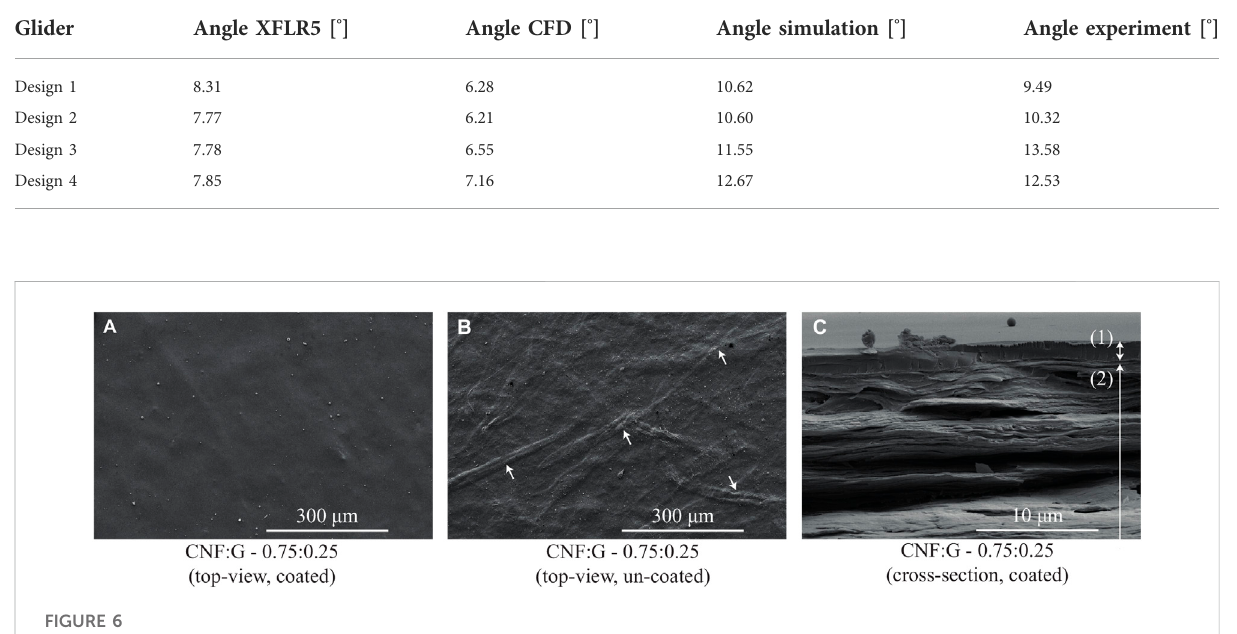
TABLE 2 Overview of the gliding angles determined in XFLR5, CFD, dynamic simulation and experiments.